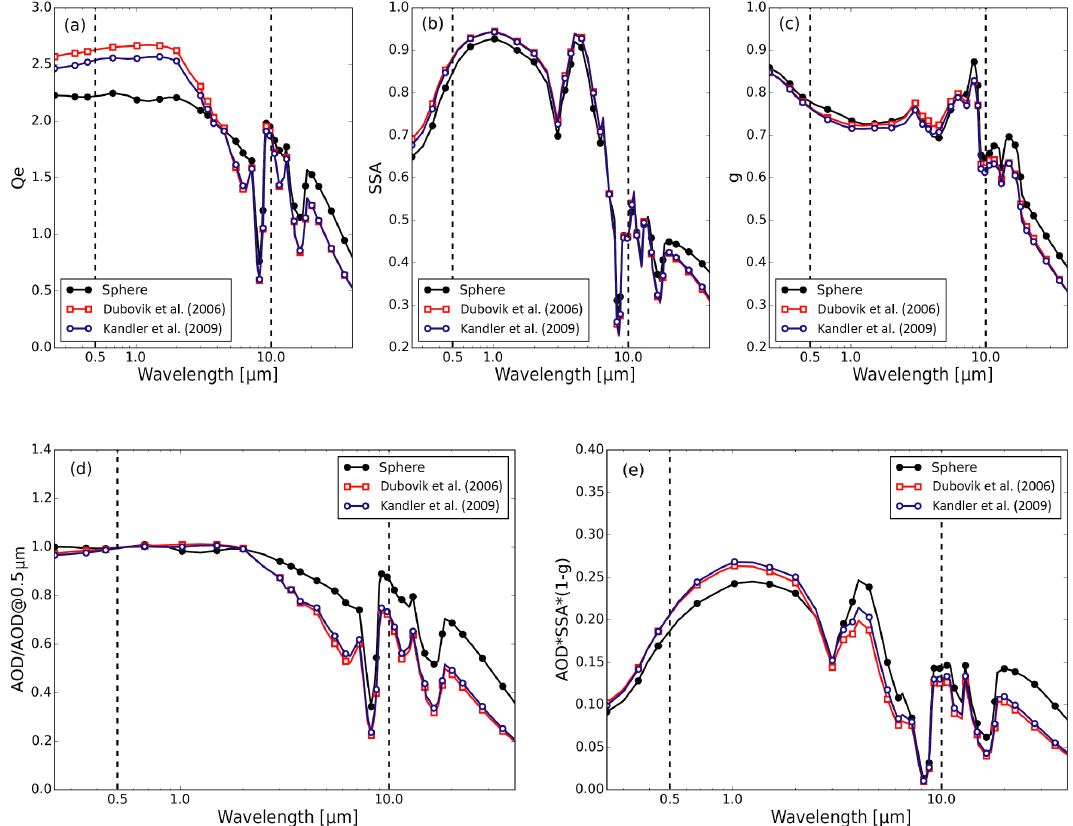
Figure 9. (a) Extinction efficiency ( Q e ), (b) single scattering albedo (SSA), (c) asymmetry factor ( g ), (d) normalized AOD with respect to AOD @ 0.5µm, and (e) AOD × SSA × ( 1 − g ) of dust aerosols based on different combinations of PSD and refractive index. PSD type and refractive index type are indicated in the